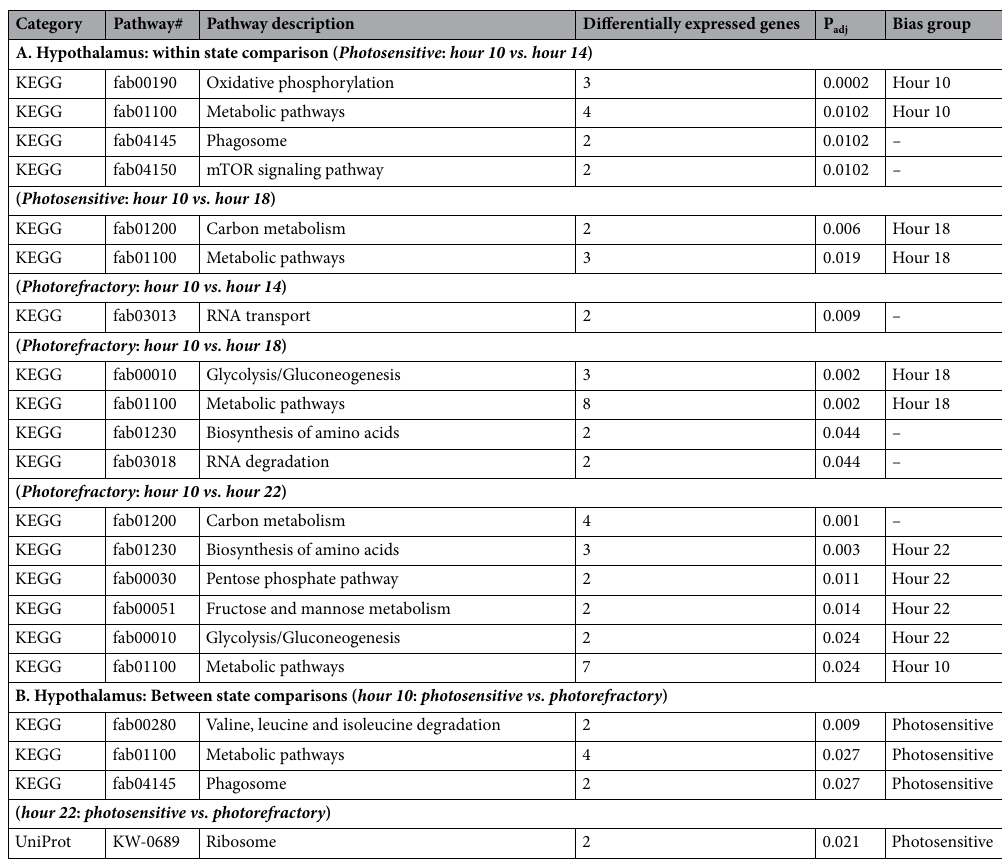
Table 1. Results of pathway enrichment of differentially expressed genes within and between state comparisons in the hypothalamus. The column on ‘bias group’ indicates the category with a higher number of upregulated genes. The blanks (-) in ‘bias group’ column indicate that the number of up- and downregulated genes in that pathway were